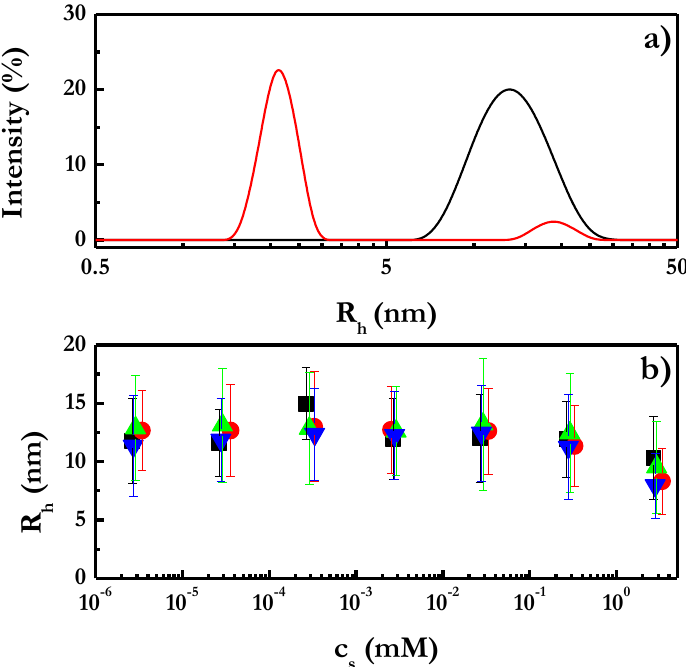
Figure 2. ( a ) Hydrodynamic radius distribution determined as the scattered intensity by DSPE-PEG for polymer solutions with a concentration of 0.5 wt% and KCl concentration of 0.3 wt% measured at two different pH values: ( ― ) 7.4 and ( ― ) 5.6. ( b ) Dependence of R h on the surfactant concentration, c s , for the different DSPE-PEG+surfactant mixtures studied in this work: ( ■ ) SLES, (●) CB, ( ▲ ) SLES+CB (molar ratio 3:2) and ( ▼ ) SLMI. All the mixtures contain a fixed DSPE-PEG concentration of 5 g/L, and their ionic strength and pH were fixed a 40 mM (KCl) and 5.6, respectively.